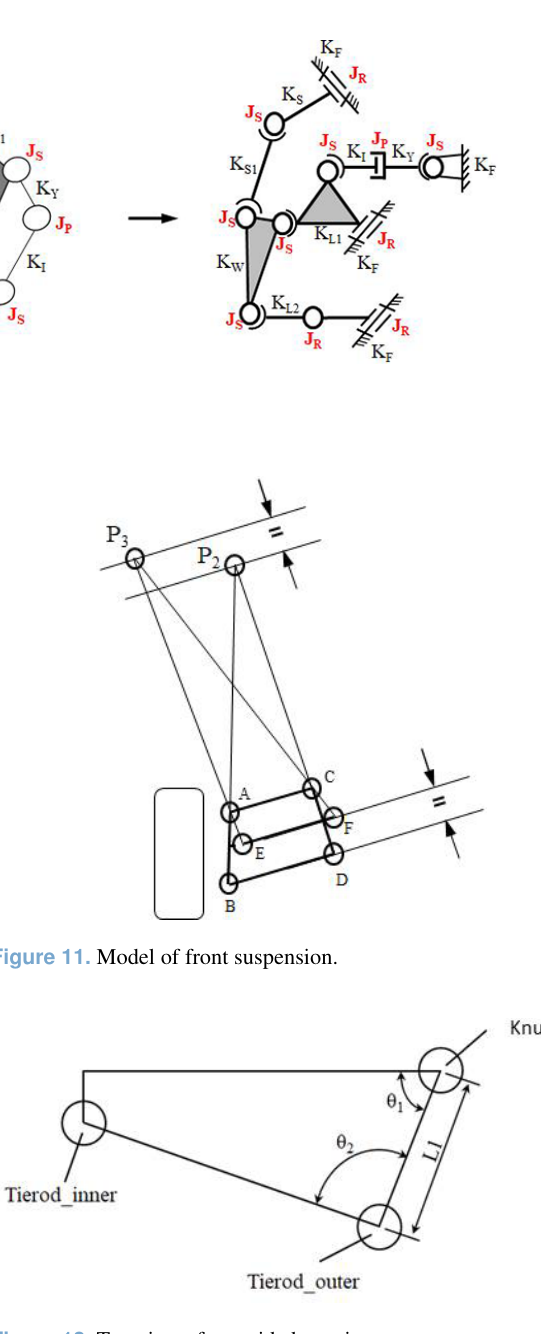
spring compression are shown in Fig. 16. The front and rear suspension velocity ratios are 1.165 and 2.447 respectively, and these values are used as the design base of the suspension stiffness.